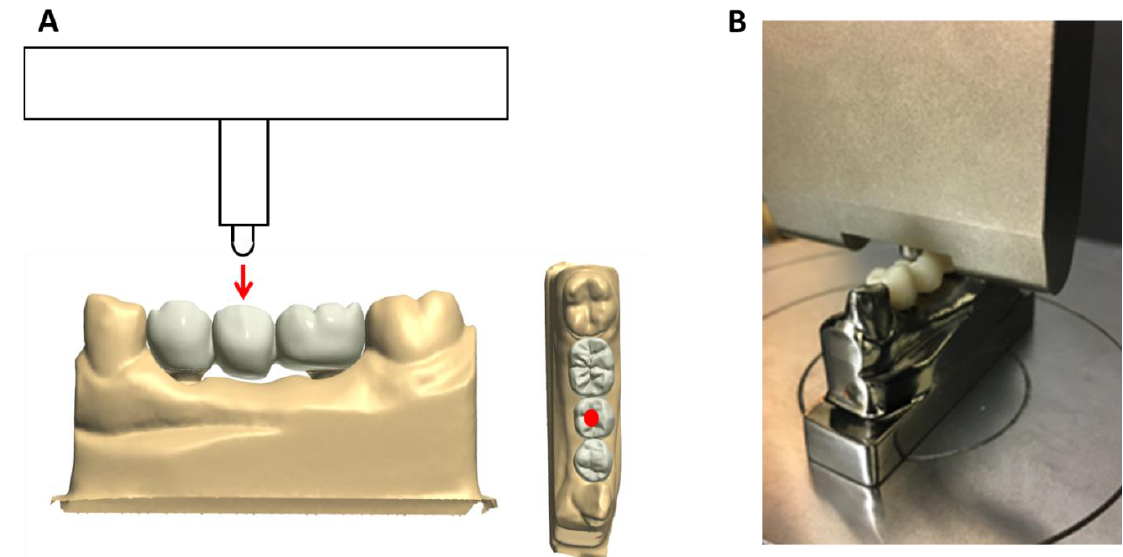
Figure 2. ( A ) Standard tessellation language file of 3-unit master fixed dental prosthesis designed in 3Shape by NDX H&O Dental Laboratory to fit the metal master typodont. The connection areas between the retainer and pontic are 4.3 × 3.3 mm 2 (mesial) and 3.4 × 4.0 mm 2 (distal). Buccal and occlusal surfaces are shown. Schematic of Instron upper anvil and red vectors indicate location of applied force. ( B ) Metal master typodont with a provisional fixed dental prosthesis attached to the universal Instron platform. Upper anvil is positioned over the pontic occlusal surface for fracture testing.